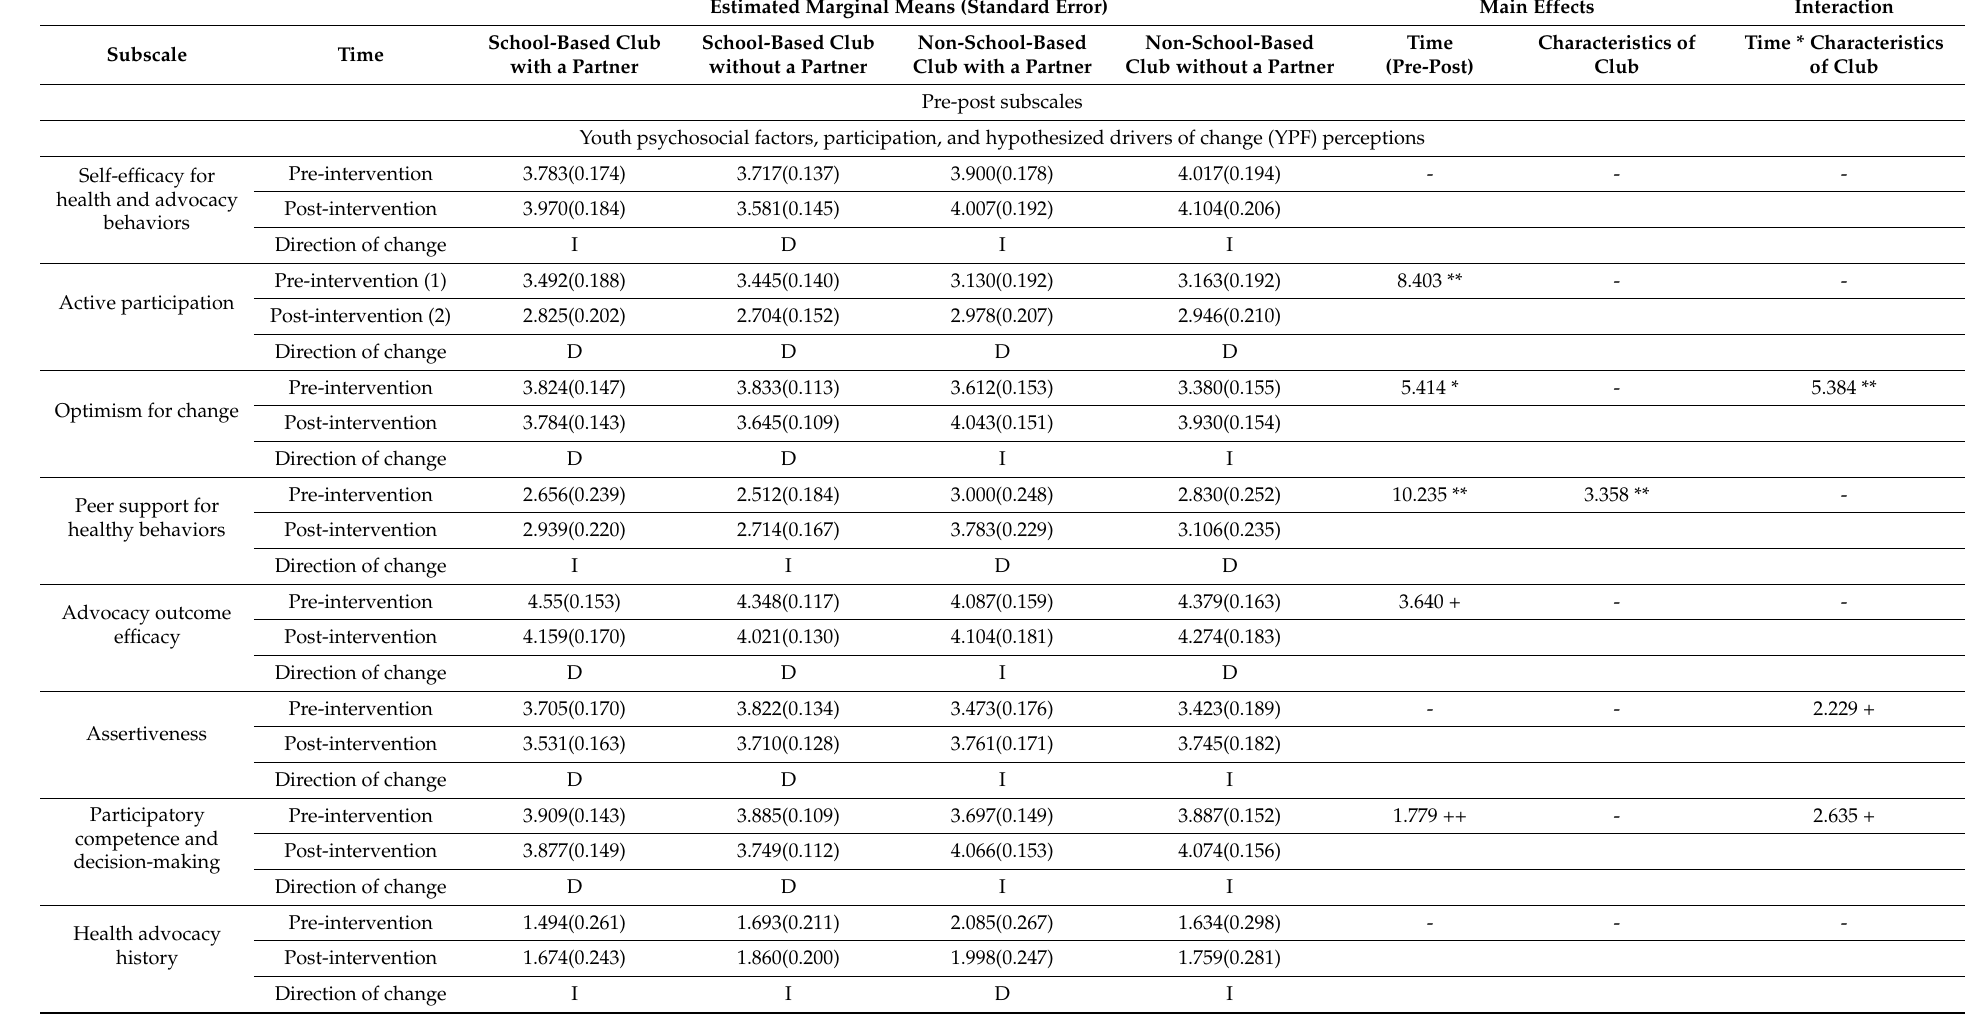
Table A3. Pre/Post-Intervention and Post-Intervention-only YEAH! Subscales: Effects of Club Type, Time, and Time-by-Club Type